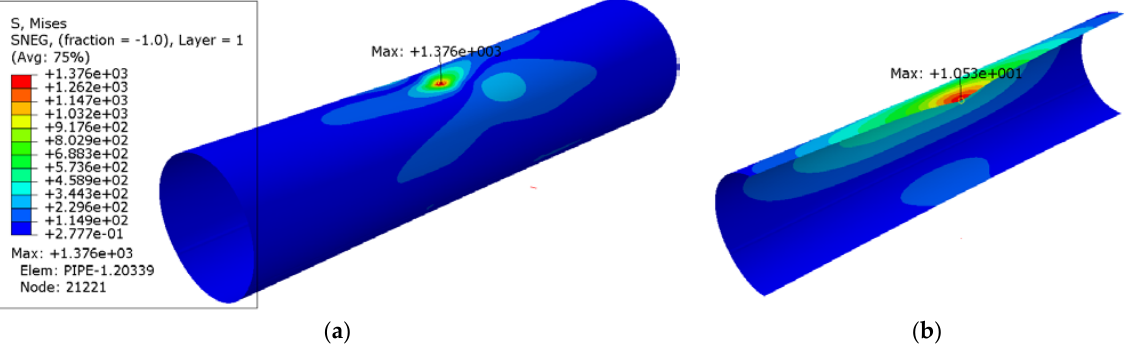
Figure 4. ( a ) Stress contour at the instant of 6 ms coincident with zero kinetic energy of impactor and ( b ) max displacement during impact.